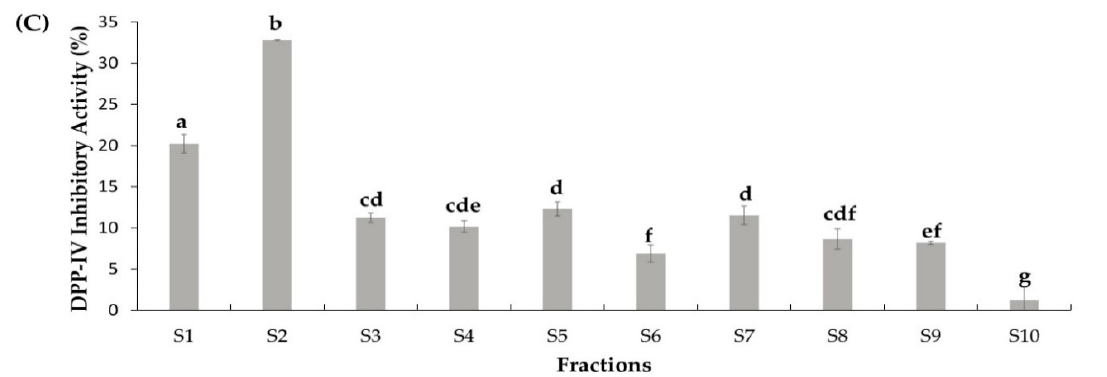
Figure 2. ( A ) Reverse-phase HPLC chromatogram with 10 mm × 250 mm, 5 µm column of turtle yolk hydrolysate. ( B ) DPP IV—Inhibition activity of RP-HPLC fractions (R1–R17). ( C ) DPP-IV inhibition activity of SCX fractions (S1–S10). Different letters (a–g) indicate significant differences between